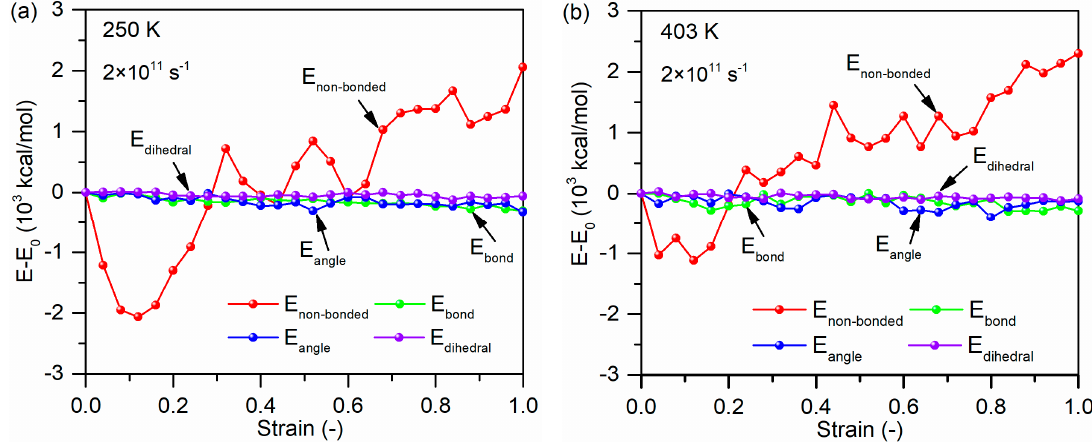
Figure 16. Potential energy decompositions of tensile process for the glass fiber / PP material system under the loading temperature of ( a ) 250 K and ( b ) 403 K.